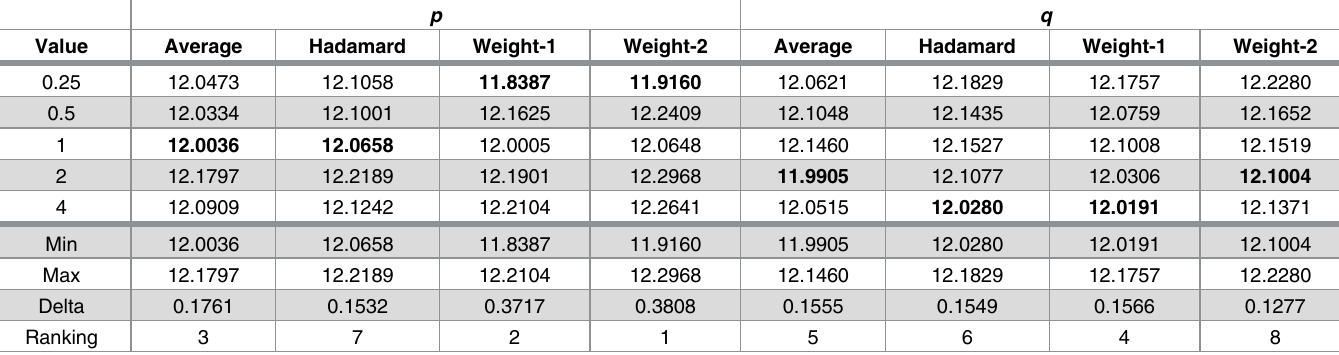
Table 7. Significance ranking of each